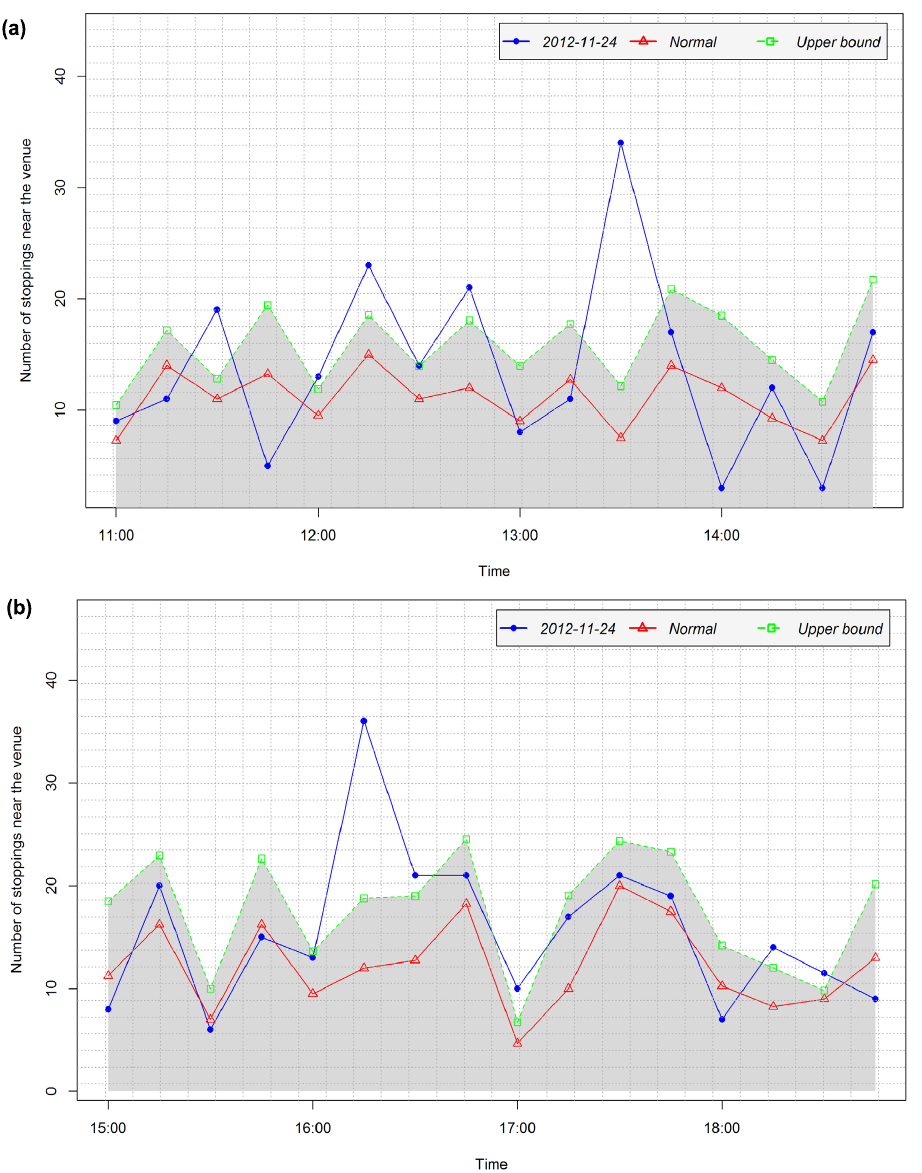
Figure 10. Temporal variation of the number of stoppings near the venue (P) , its normal value ( Q ), and its upper bound ( UP ) during the period around ( a ) arrival time; and ( b ) departure time on 24 November 2012.